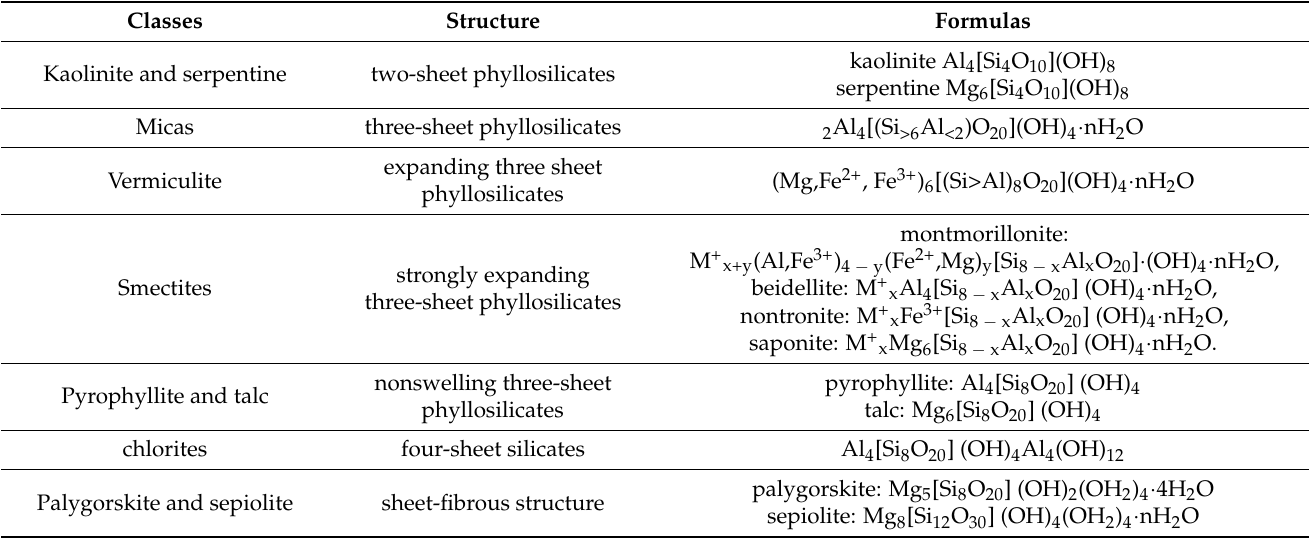
Table 1. Classification of clay minerals